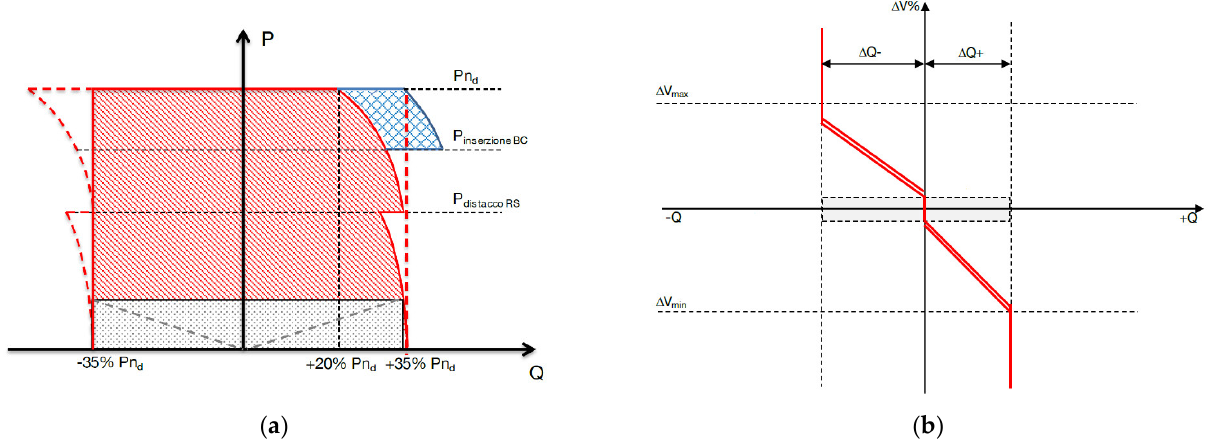
Figure 16. Capability curve implemented for wind and PV plants ( a ) [53,54], Q/V curve given by Terna in [55] ( b ).